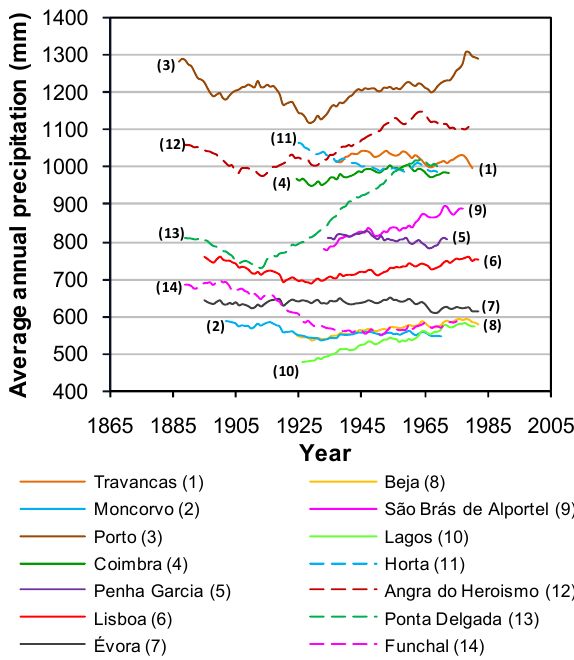
Fig. 3. The 50-year moving average series of the annual precipitation from Portugal; the data from the islands are plotted with dashed lines. The data are centred on the 50-year window. See also Table 3.